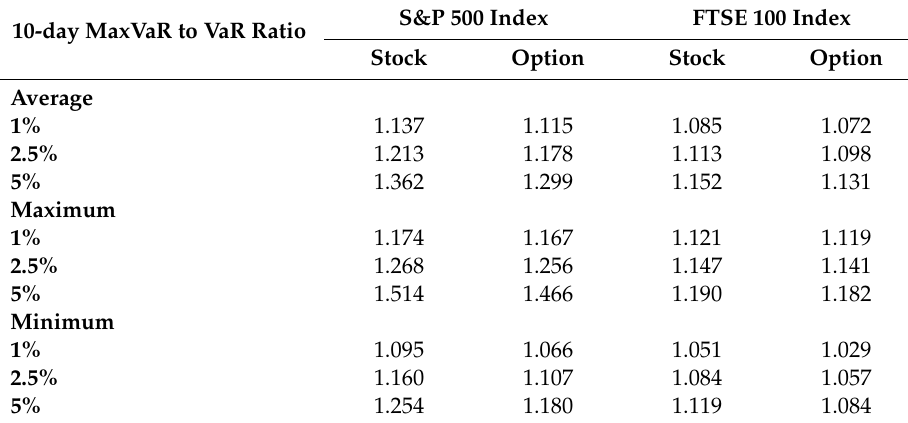
Table 8. Summary statistics for the 10-day Inflation factor.